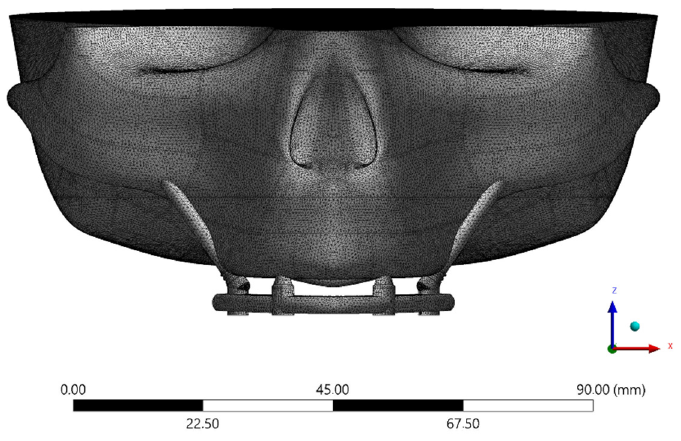
Figure 4. Meshing division created with tetrahedral elements during the pre-processing step.